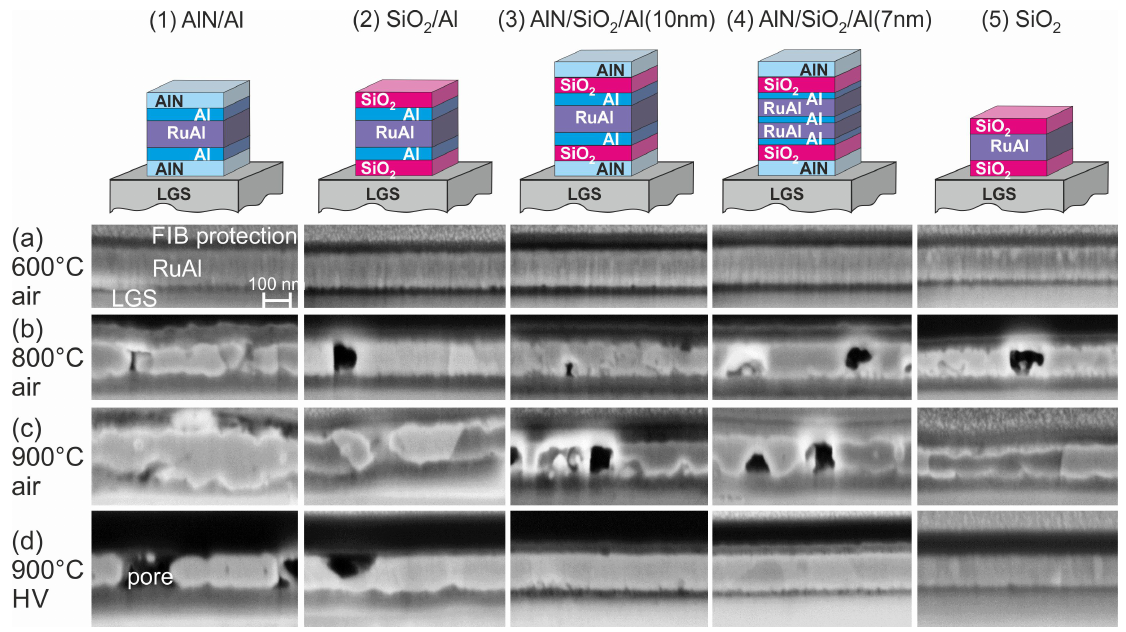
Figure 5. SEM images (inLens, 3 kV) of cross-sections of the RuAl thin films with various protection layers on LGS after annealing in air for 10 h at ( a ) 600 ◦ C, ( b ) 800 ◦ C, ( c ) 900 ◦ C, and ( d ) in high vacuum at 900 ◦